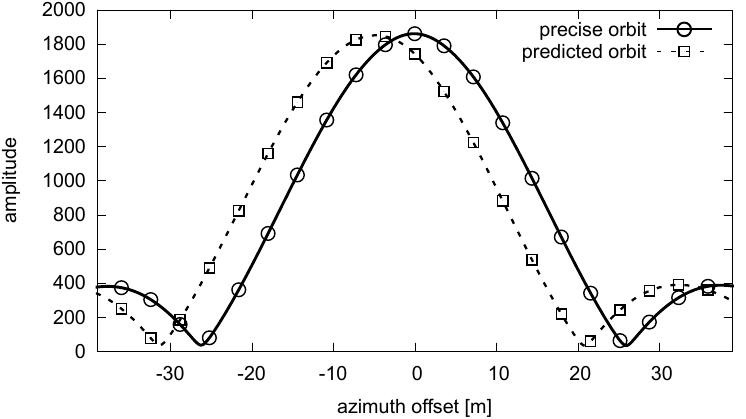
Figure 4. Amplitude of azimuth compressed data for different orbit data; each circle represents an individual range line. A complex interpolation is applied to improve the resolution (lines). In case of precise geometry information (precise orbit data), the maximum matches at the origin with a low remaining azimuth offset of 7 cm. Using a predicted orbit, an azimuth offset of about 5 m occurs due to more inaccurate positions and timestamps of the